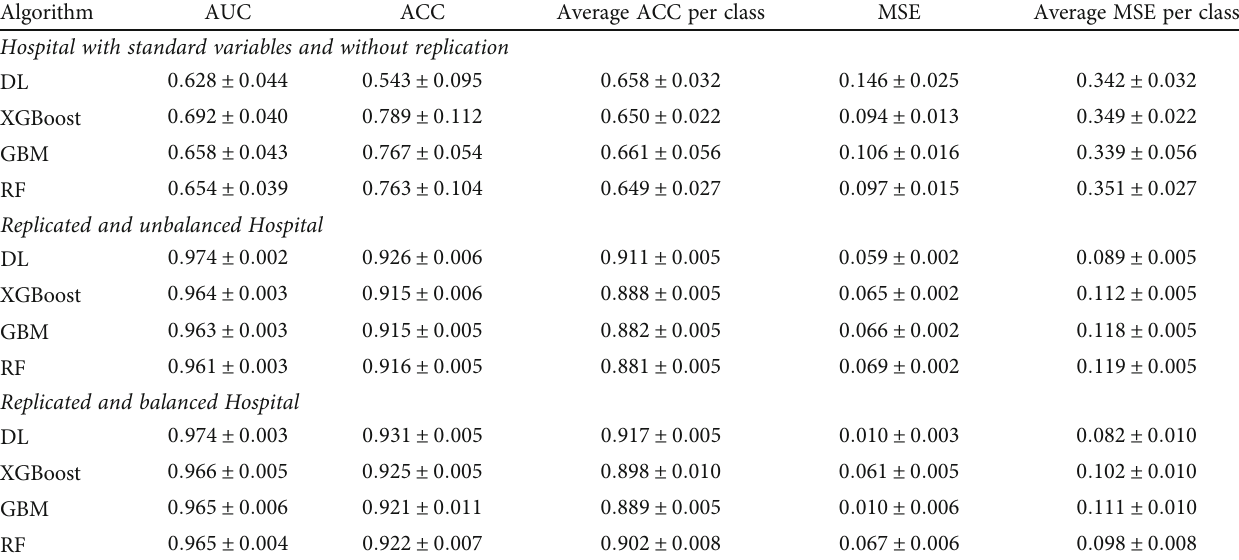
Table 18: Results with standard deviation of predictor classi fi cation using h2o in Hospital.